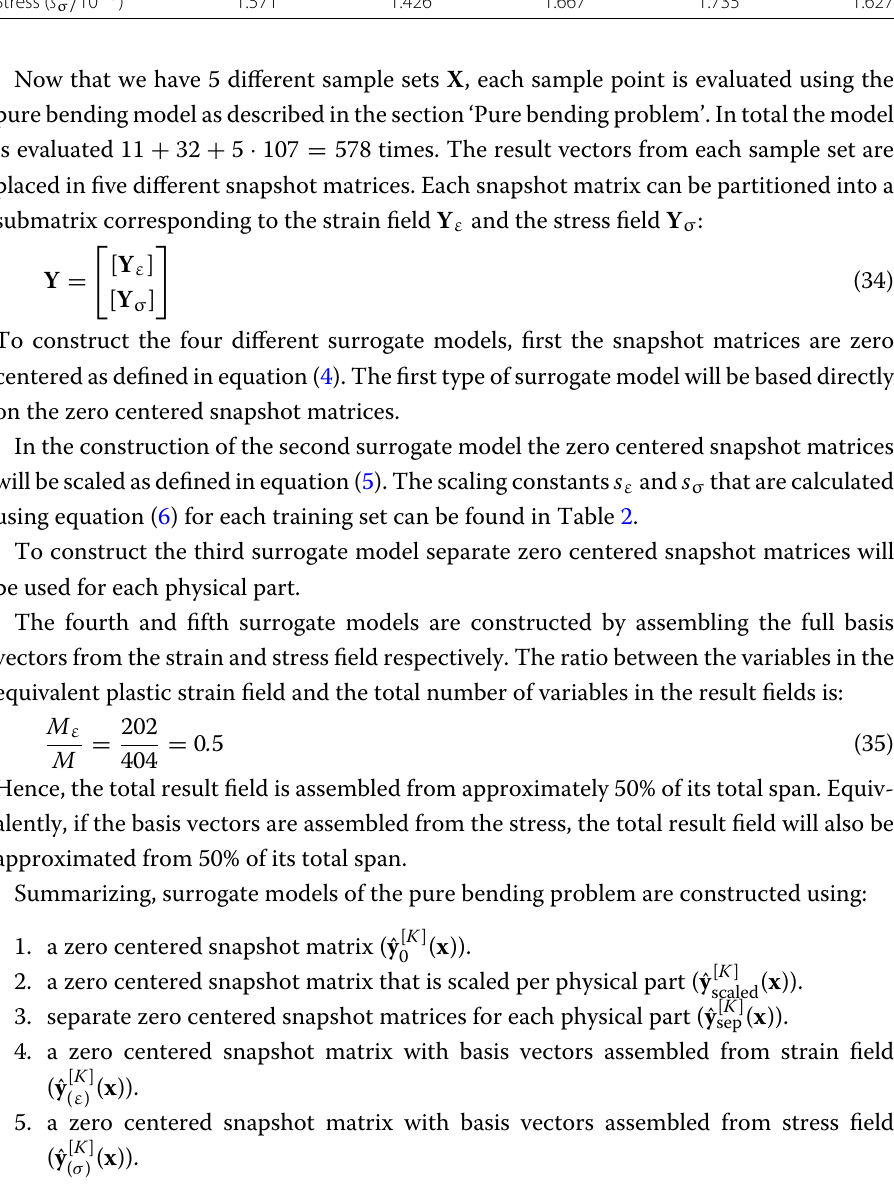
Table 2 Scaling constants for the different training sets of the pure bending problem Set 1 Set 2 Set 3 Set 4 Set 5 Strain ( s ε ) 8.747 8.800 Stress ( s σ / 10 − 3 )